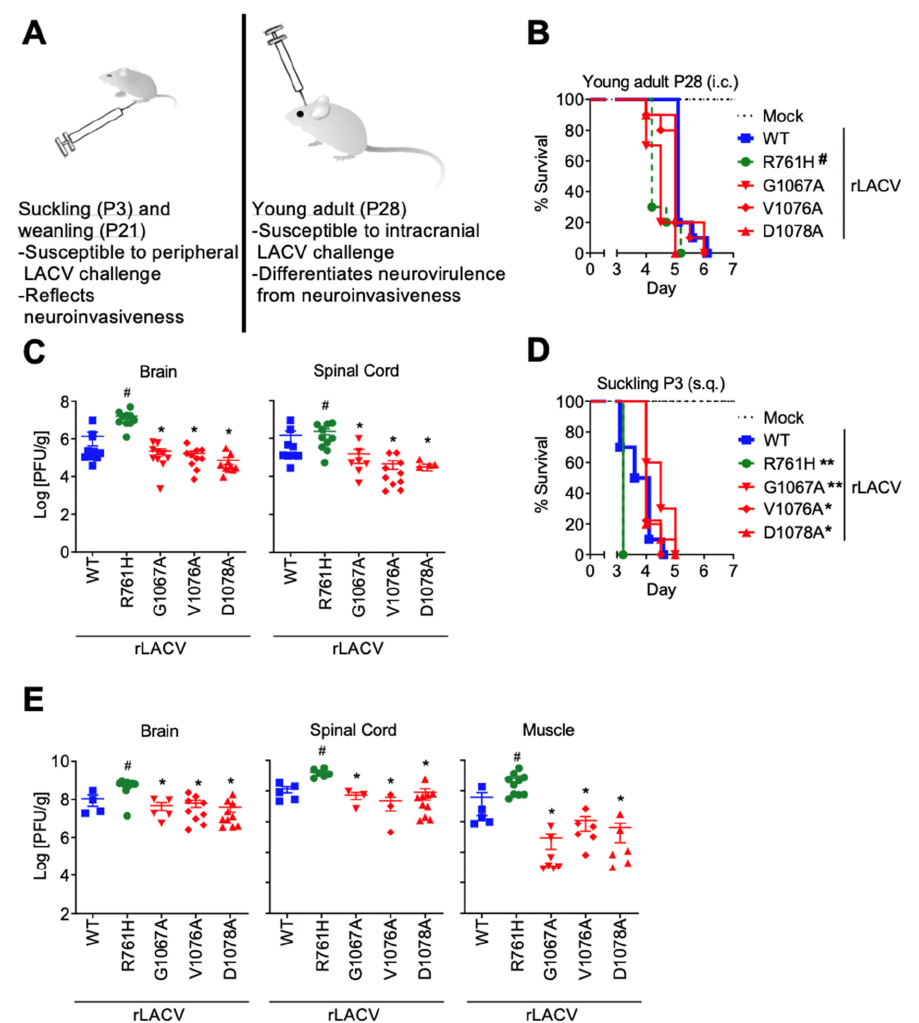
Figure 2. Fusion peptide mutant rLACVs have lower viral loads in key tissues and are less neuroin- vasive, but remain neurovirulent in vivo. ( A ) The murine model of LACV encephalitis differentiates determinants of neuroinvasion from neurovirulence. ( B ) Four-week-old mice were inoculated in- tracranially with 10 PFU of rLACV-WT, the tryptic site mutant (rLACV-R761H), or the fusion peptide domain mutants rLACVs (G1067A, V1076A, and D1078A). There were no significant differences in the survival rates of young adult (P28) mice inoculated with rLACV-WT compared to those inoculated with the fusion peptide mutant rLACVs. Interestingly, young adult (P28) mice inoculated with the tryptic site mutant virus died significantly earlier than mice inoculated with rLACV-WT (Log-rank (Mantel–Cox) test; # p < 0.001; n = 10 per group). ( C ) Fusion peptide mutant viruses grew to lower titers in the brains and spinal cords of young adult (P28) mice compared to rLACV-WT (* p < 0.05). The tryptic site mutant rLACV grew to higher titers in the brains and spinal cords (# p < 0.05 increase). ( D ) Suckling (P3) mice were inoculated subcutaneously with 5 PFU of the rLACVs ( n = 10 per group, except n = 9 for V1076A). Suckling (P3) mice challenged with the fusion peptide mutant viruses (rLACV-G1067A, rLACV-V1076A, and rLACV-D1078A) survived longer than those inoculated with rLACV-WT. As with the young adult (P28) mice, suckling (P3) mice challenged with the tryptic site mutant rLACV-R761H died significantly earlier than mice inoculated with rLACV-WT (Log-rank (Mantel–Cox) test; * p < 0.05; ** p < 0.01). ( E ) Fusion peptide mutant rLACVs grew to lower titers in the brains, spinal cords, and muscle of suckling mice challenged subcutaneously (* p < 0.05; # p <